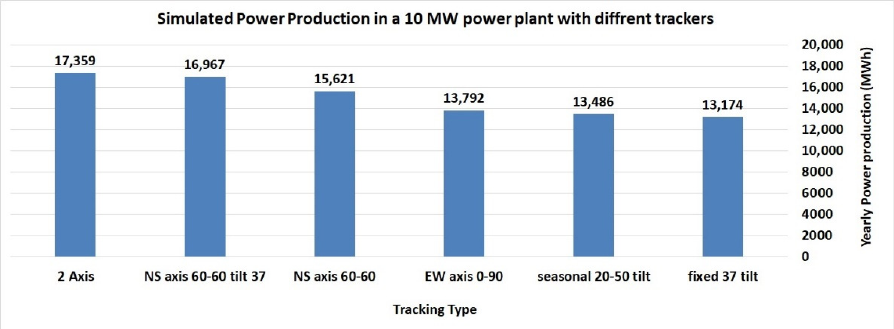
Figure 14. Energy production in different tracker installation scenarios.